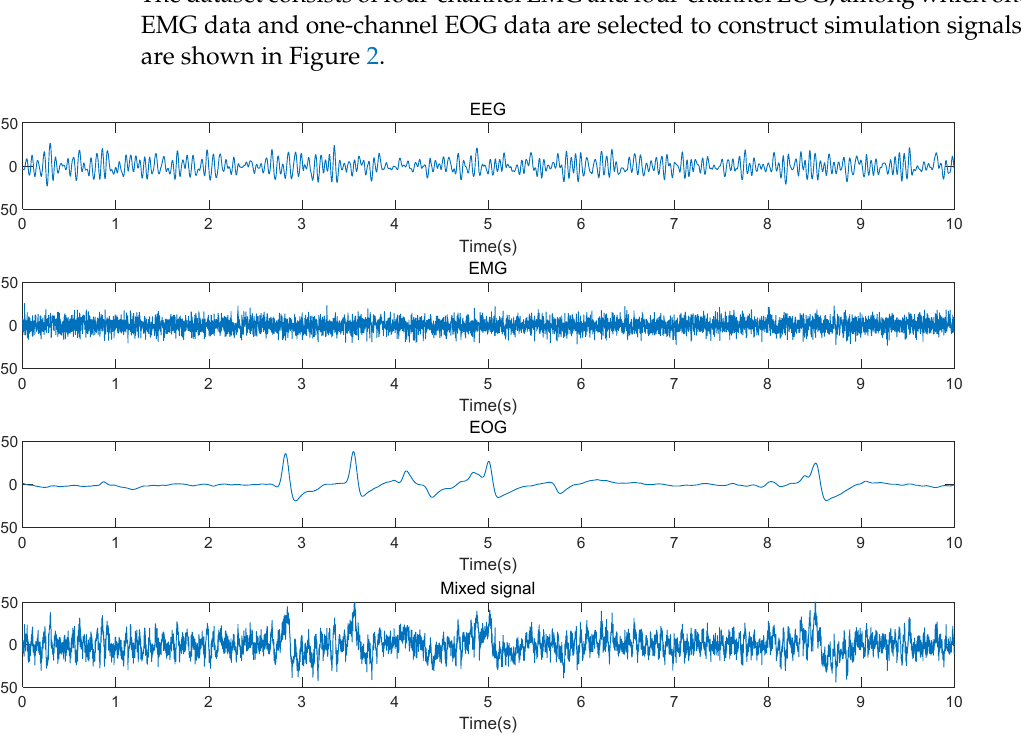
Figure 2. Time domain diagram of simulation signal.